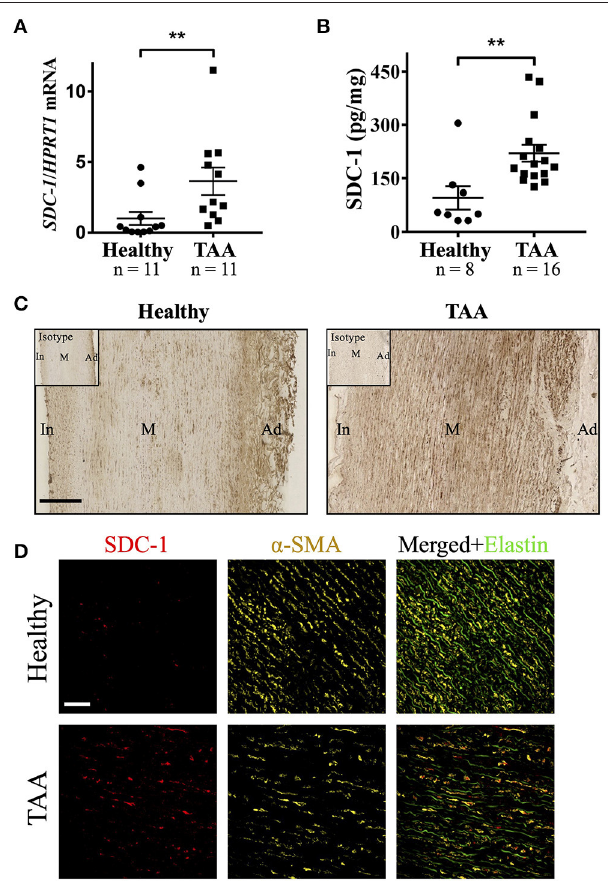
FIGURE 1 | SDC-1 mRNA and protein levels are increased in the media layer of human TAA compared to healthy counterparts and is expressed by SMCs. (A) mRNA expression level of SDC-1 in the media layer of healthy aorta and TAA was measured by RT-qPCR and normalized to HPRT1. (B) The abundance of SDC-1 protein in human aortic media was assessed by ELISA from healthy or TAA donors. (C) Representative images of SDC-1 staining by immunohistochemistry in healthy human and TAA media. Staining with an isotype control was performed as a negative control and shown on the top left of images. Scale bar corresponds to 200 µ m. In, intima; M, media; Ad, adventitia. (D) Representative immunofluorescence images of SDC-1 (red) and α -SMA (yellow) co-staining in the media of healthy human or TAA media. Green color corresponds to elastin autofluorescence in the merged images. Scale bar corresponds to 50 µ m. (A,B) Data are presented as mean ± SEM and p -values were calculated using non-parametric two-tailed Mann-Whitney test; ** p <